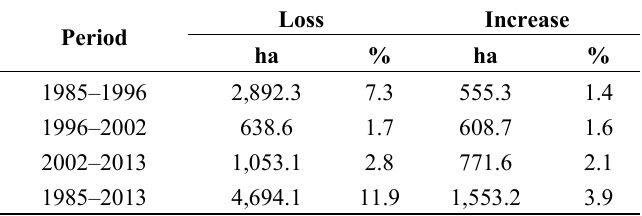
Table 3. Changes in the area of mangrove forests between 1985–1996, 1996–2002, and 2002–2013. The loss and increase of mangrove forests in percentage are calculated as: – s )/ s × 100, where s and s are the areas of the mangrove forests and non-mangrove ( s j i i j i forests classes in the i th and j th years,